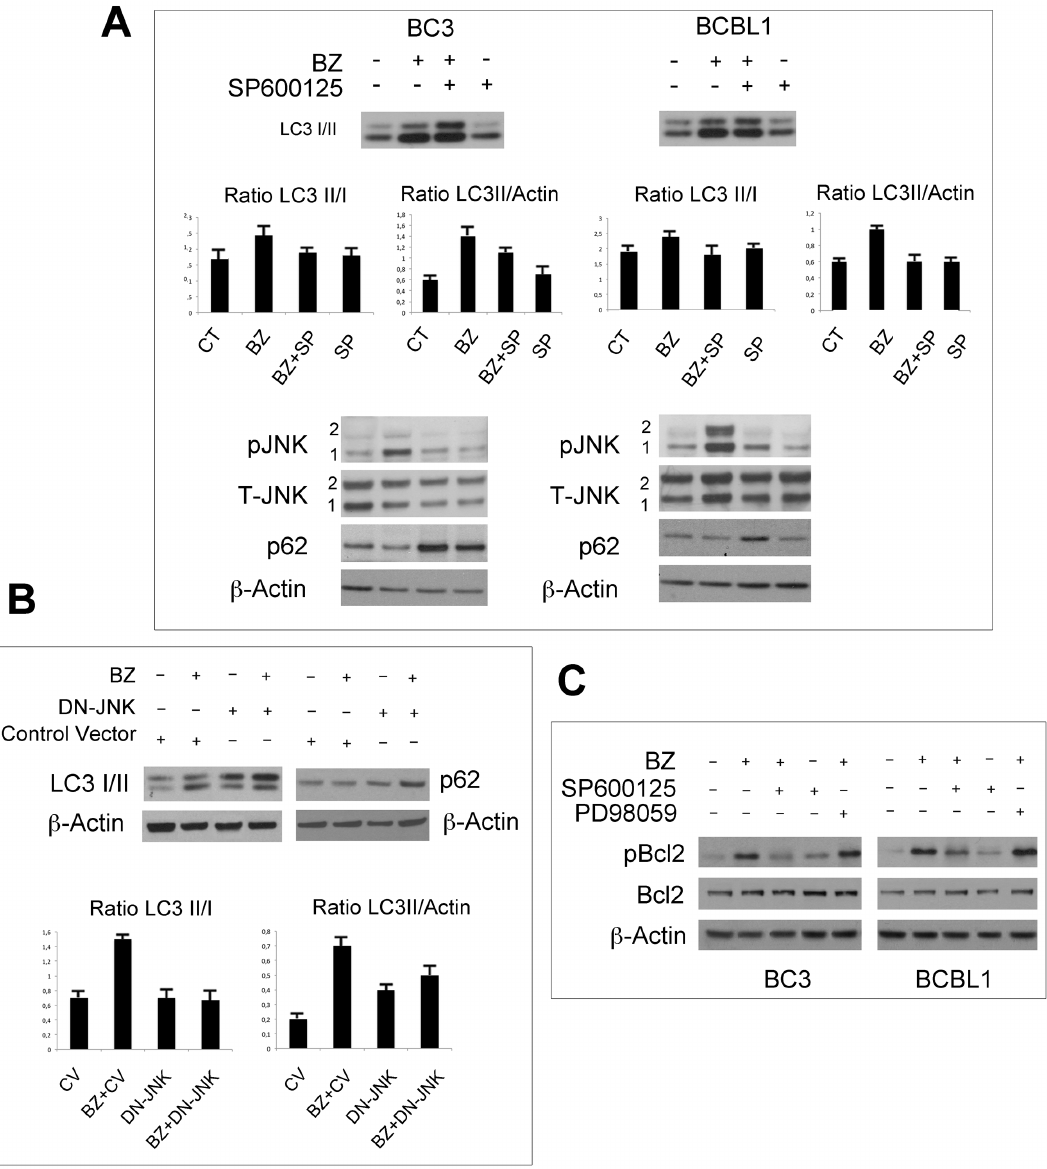
Figure 3. Bortezomib induces autophagy in JNK-dependent manner. (A) BC3 and BCBL1 cells were treated with bortezomib (20 nM for 16 hrs) with or without pre-treatment with JNK inhibitor (SP600125) (20 m M). Total cell lysates were prepared and immunoblotted with the following antibodies: anti-LC3, anti-pJNK, anti-T-JNK and anti-p62. Anti- b -actin was used as loading control. The histograms indicate LC3-II/I and LC3-II/Actin ratio based on densitometric analysis (mean 6 the standard deviation, n=3 experiments). (B) BC3 cells were transfected with DN-JNK expression vector or with an control empty vector (CV) and after 16 hrs treated with bortezomib (20 nM) for an additional 16 hrs. Total cell lysates were prepared and immunoblotted with anti-LC3 and p62 antibodies. b -actin was used as internal control. The histograms indicate LC3-II/I and LC3-II/Actin ratio based on densitometric analysis (mean 6 the standard deviation, n=3 experiments). (C) BC3 and BCBL1 cells were treated with Bortezomib (20 nM) alone or in combination with JNK inhibitor (SP600125) (20 m M) or ERK inhibitor (PD98059) (10 m M) for 16 hrs. A western blotting was performed using the following antibodies: anti-pBcl2(S70) and anti-total Bcl2. b -actin was used as loading control.